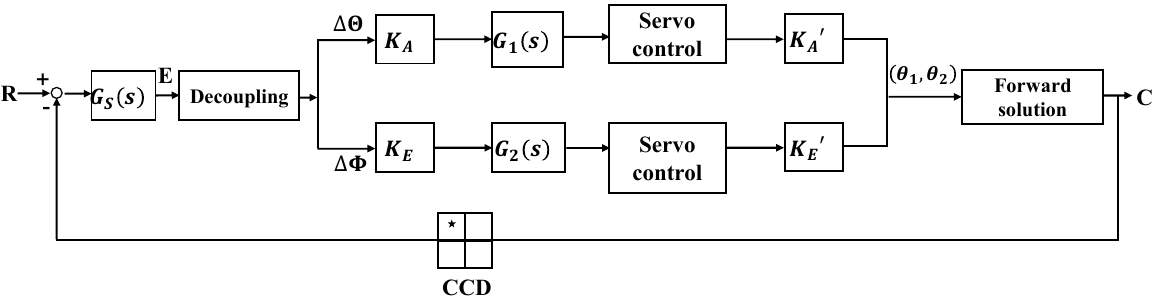
Figure 3. Schematic diagram of IBCLT for the Risley prism.